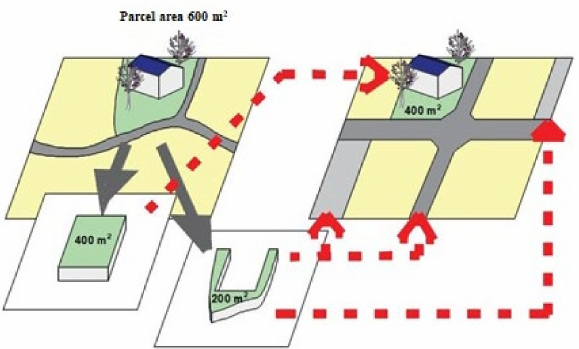
Figure 1. Urban consolidation in the function of urban development of